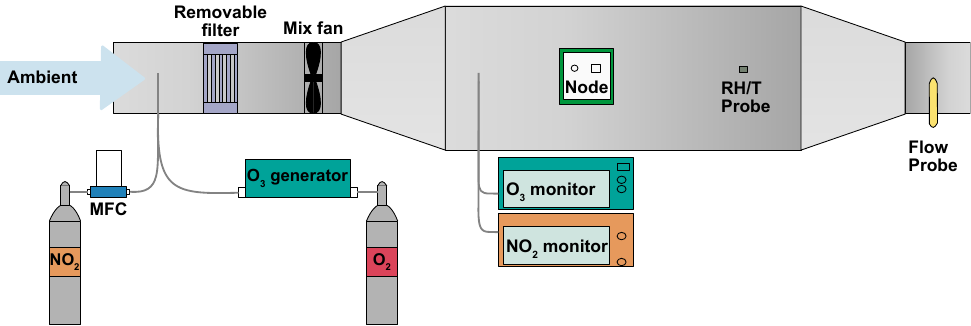
Figure 6. EASE calibration setup. This schematic is representative of the setup used for both MOx and EC calibration.